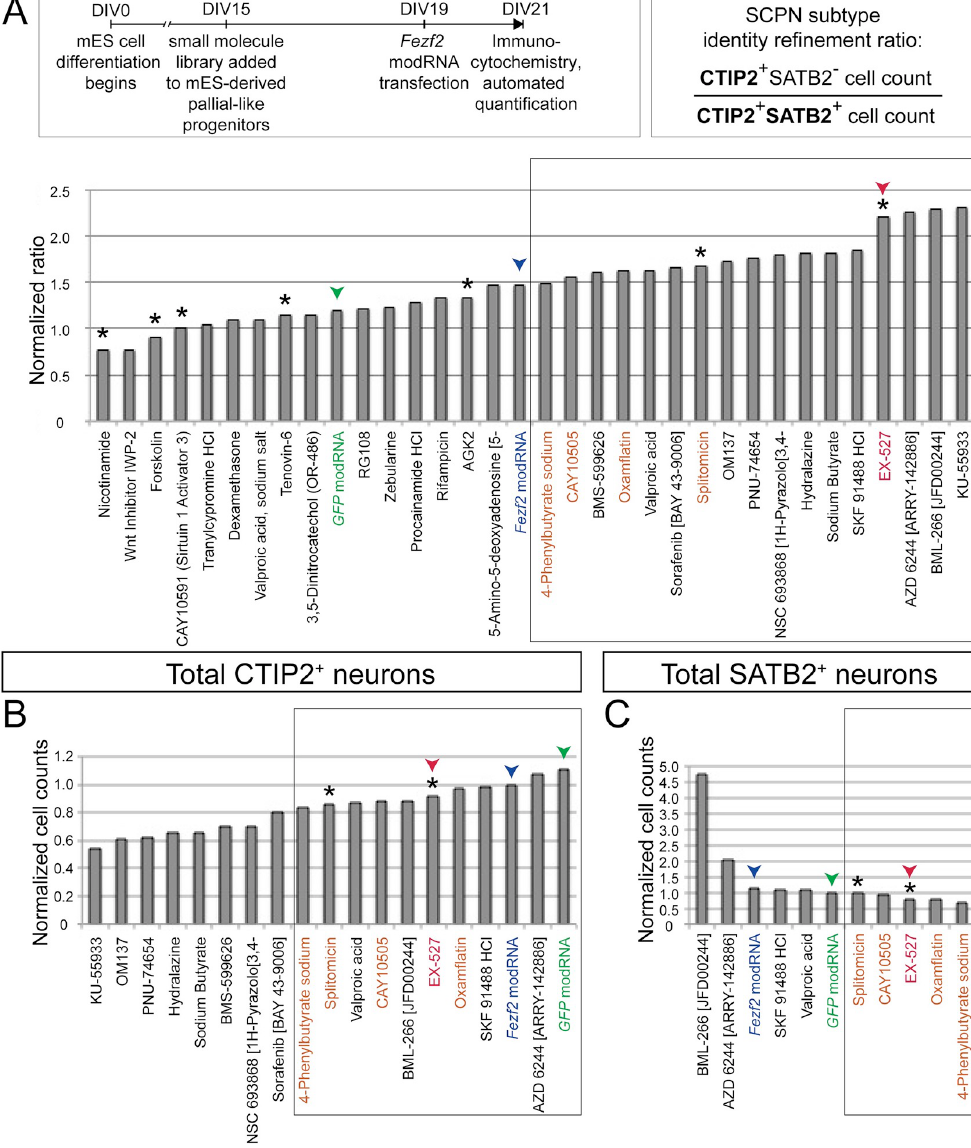
Fig 2. High-content small molecule screen of SCPN/CSN molecular refinement by mES-derived neurons identified candidate small molecule regulators, including the SIRT1 inhibitor EX-527. (A) Each well of a 96-well plate containing ES-derived neurons at 15 days in vitro (DIV) was incubated with a distinct small molecule from the library (S3 Fig) at a concentration of 1 micromolar for four days, transfected with GFP or Fezf2 modRNA at 19 DIV with a transfection efficiency of approximately 20%, then incubated for an additional 48 hrs, and analyzed in a blinded manner at 21 DIV. Distinct small molecules enhanced, inhibited, or did not substantially alter Fezf2 -mediated SCPN subtype refinement, as indicated by the ratio of CTIP2(+)/SATB2(-) neurons to CTIP2(+)/SATB2(+) neurons. The ratios were normalized to the untreated condition. (B) Some candidate small molecules, from the box marked in (A), altered the number of CTIP2-expressing neurons, relative to the Fezf2 induction condition. A subset of candidates that preserved the highest number of CTIP2+ neurons were chosen for the subsequent analysis. The total CTIP2+ cell counts were normalized to the Fezf2 modRNA condition. (C) Candidate small molecules, from the box marked in (B), decreased the number of SATB2-expressing neurons relative to Fezf2 induction alone; these top candidates are enclosed in a new box and highlighted in orange text (in order to identify them in the prior analyses in panels A and B); they include the SIRT1 inhibitor EX-527. The total SATB2+ cell counts were normalized to the GFP modRNA condition. Asterisks indicate small molecules that modify HDAC Class III (Sirtuin). Green arrowheads and text color indicate the GFP transfection condition and the blue arrowheads and text color indicate the Fezf2 transfection condition, for comparison. The red arrowheads and text color indicate the EX-527 condition, a relatively specific SIRT1 inhibitor. Data from this first-level, blinded screen experiment (N = 1; the COVID pandemic